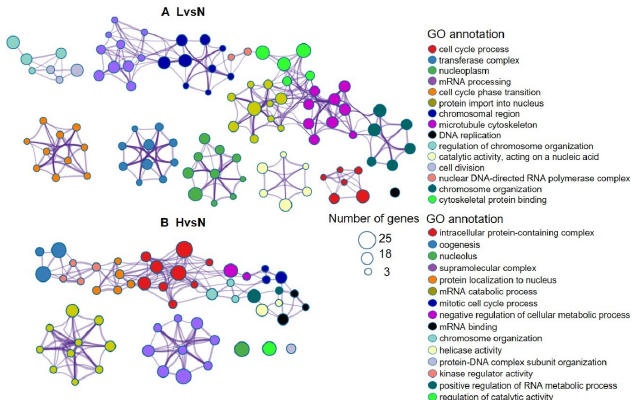
Figure 4. Gene Ontology (GO) enrichment terms of the annotated genes. ( A ) GO enrichment for